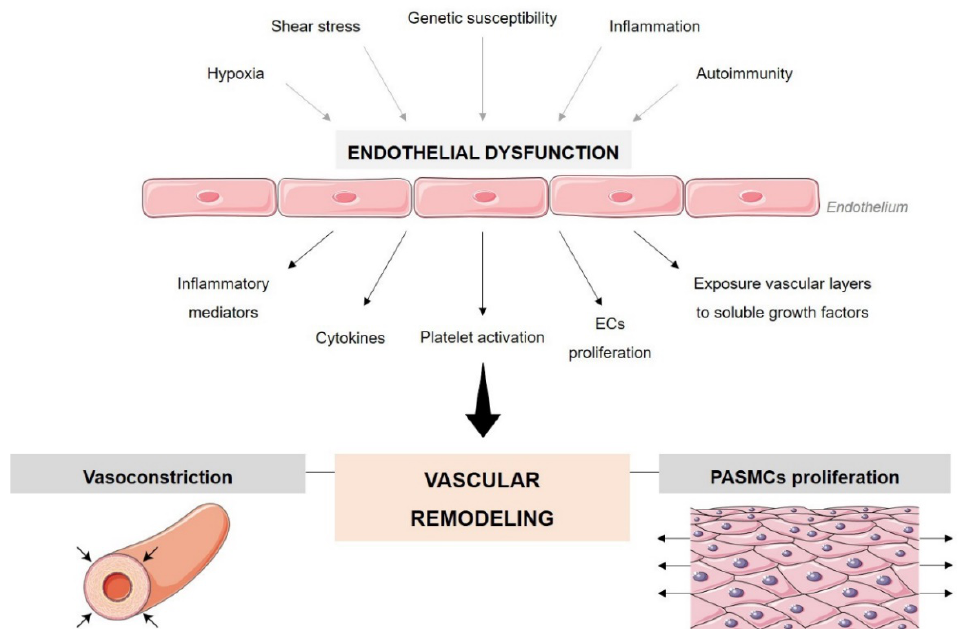
Figure 2. Schematic representation of the role of endothelial dysfunction in pulmonary hypertension and pulmonary vascular remodeling. Endothelial cells (ECs); pulmonary arterial smooth muscle cells (PASMCs).